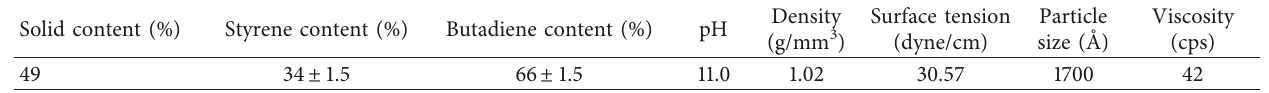
Table 5: Properties of SB latex.